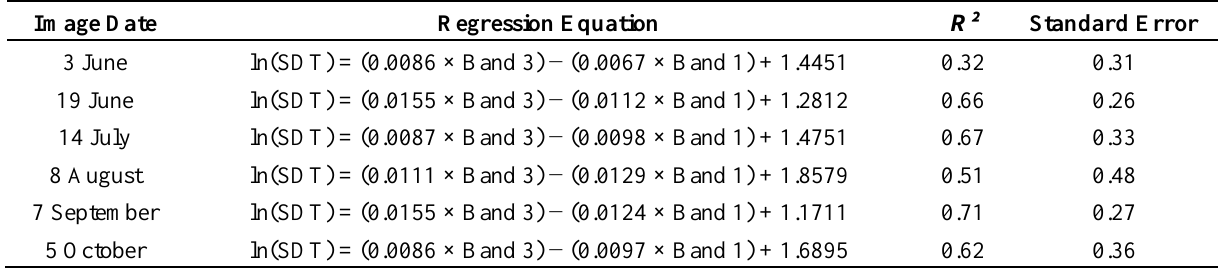
Table 4. Regressions for each MODIS image date, shown with coefficient of determination and standard error.